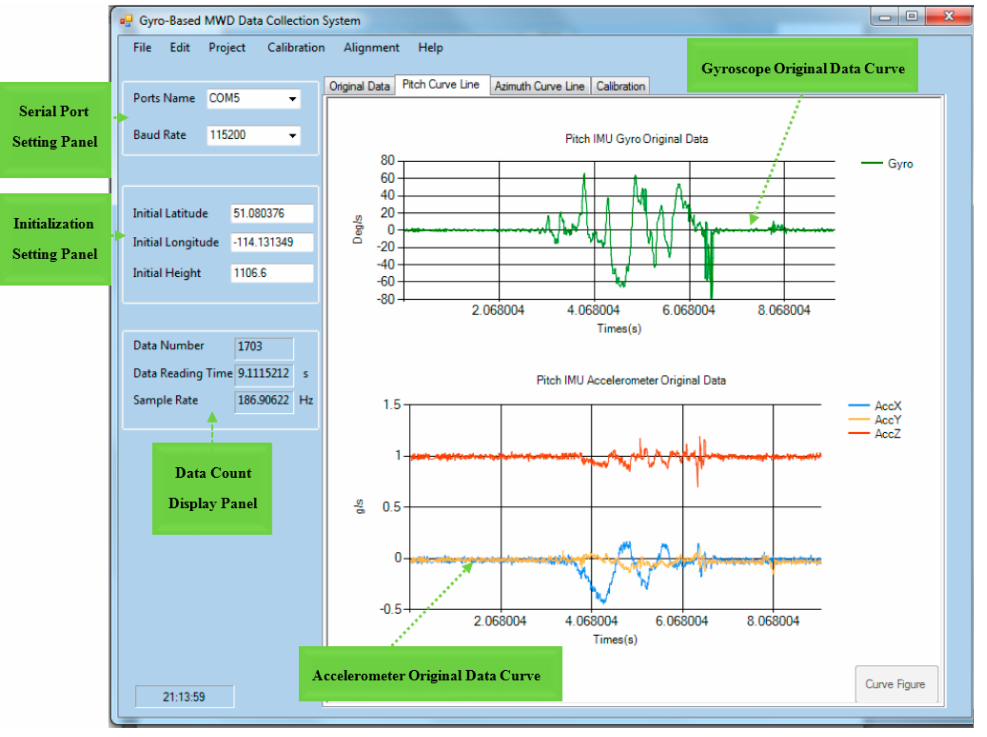
Figure 5. MGWD data collection software interface.